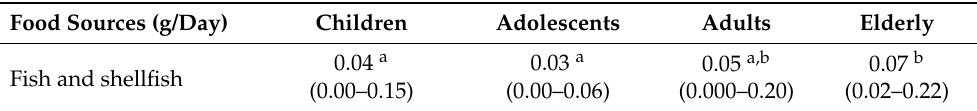
Table 16. Contribution of dietary food sources to docosahexaenoic acid (DHA) intakes per age group among the ANIBES Study population.